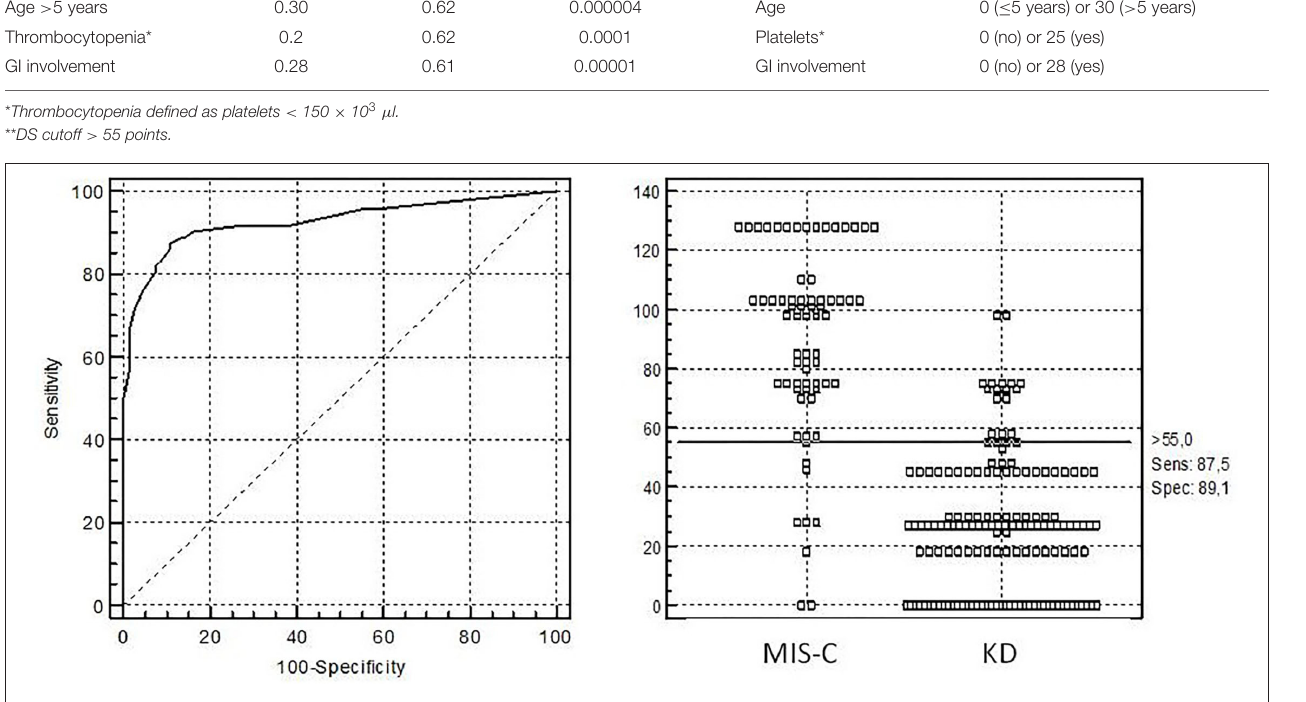
11.5), p = 0.005], pericarditis [OR = 7.1 (95% CI: 2.4,